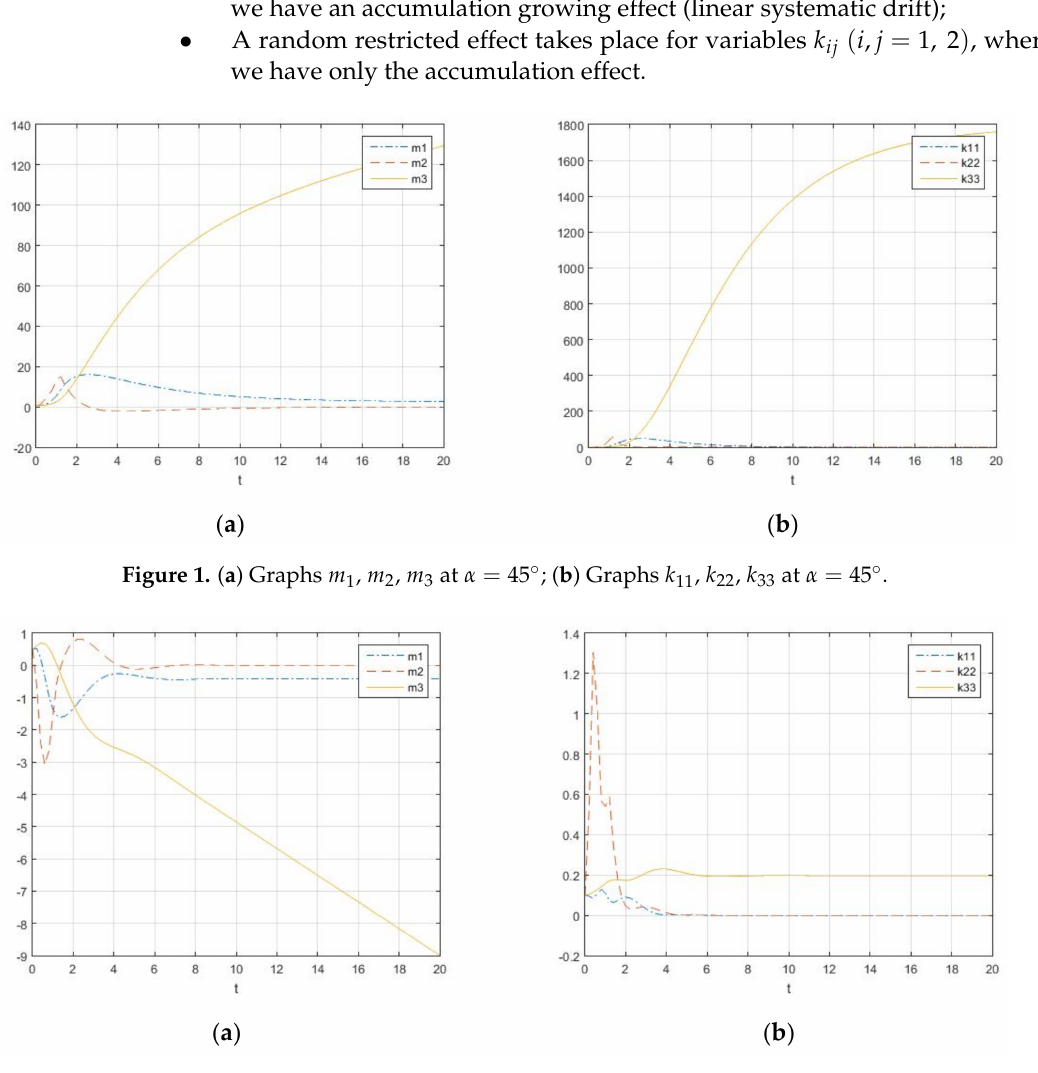
Figure 2. ( a ) Graphs m 1 , m 2 , m 3 at α = 225 ◦ ; ( b ) Graphs k 11 , k 22 , k 33 at α = 225 ◦